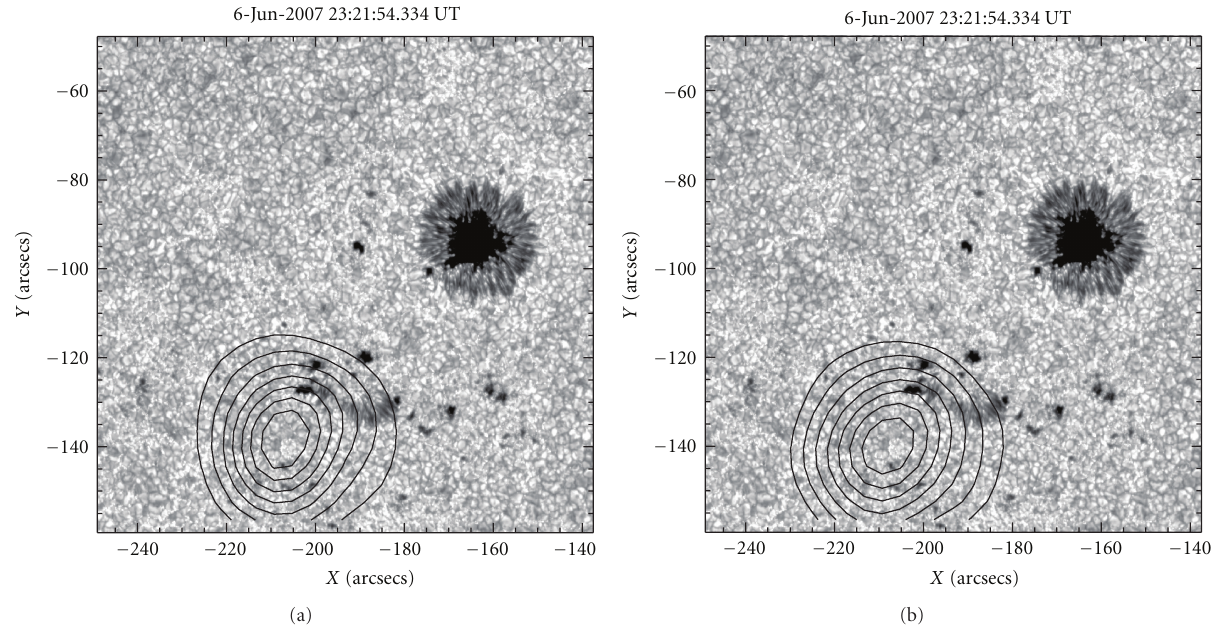
Figure 7: The contours of the RHESSI hard X-ray images overlaid upon the G-band images. (a) The contours of 6 to 12keV and (b) 12 to 25keV.